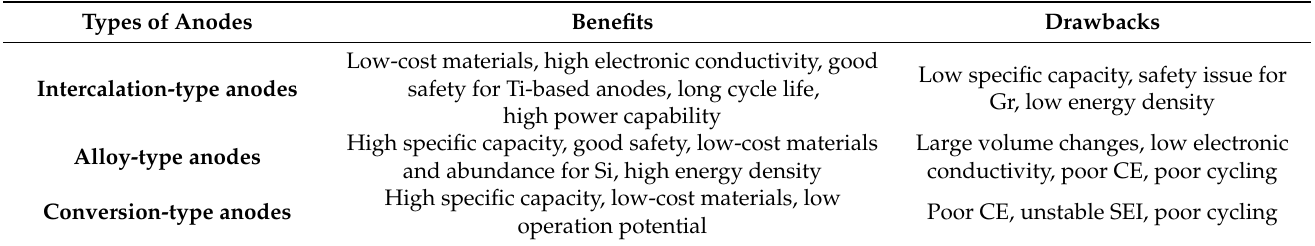
Table 1. An overview of the (dis)advantages of different types of anodes. Types of Anodes Benefits Drawbacks Low-cost materials, high electronic conductivity, good Intercalation-type anodes safety for Ti-based anodes, long cycle life, high power capability High specific capacity, good safety, low-cost materials Alloy-type anodes and abundance for Si, high energy density Conversion-type